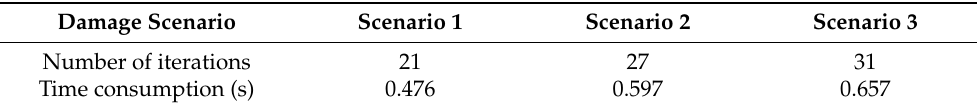
Table 4. The number of iterations and time consumption for convergence under different damage